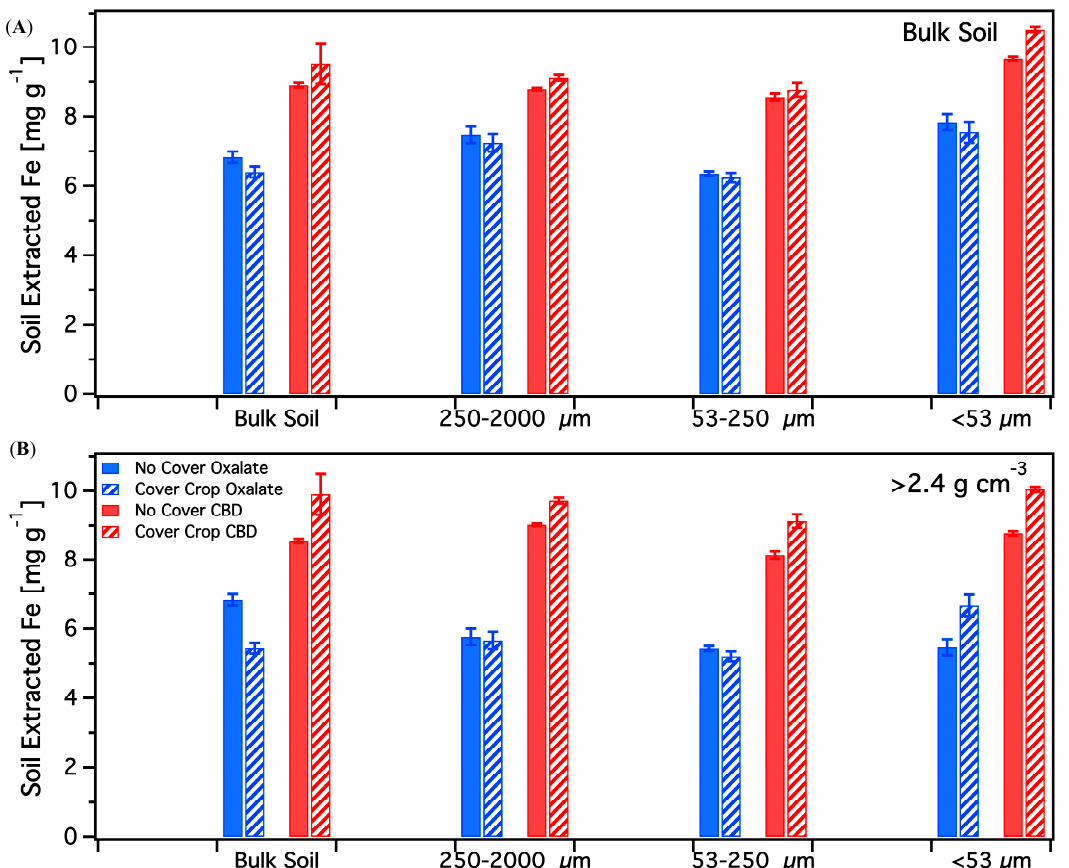
Figure 5. Acid ammonium oxalate (blue bars) and citrate-bicarbonate-dithionite (red bars) extractable Fe for no cover crop (solid bars) and cover crop (dashed bars) soils. Values are expressed as mg Fe per g dry soil mass for ( A ) bulk soil and aggregate size fractions, and ( B ) the heaviest density fraction (>2.4 g cm − 3 ) of bulk soil and aggregate size fractions. Error bars represent ± standard error. Differences between cover crop and no cover crop were significant for the CBD extraction of 250–2000 µm size fraction ( p = 0.1) and for the oxalate extraction of bulk soil and bulk >2.4 g cm − 3 density fraction ( p = 0.01).